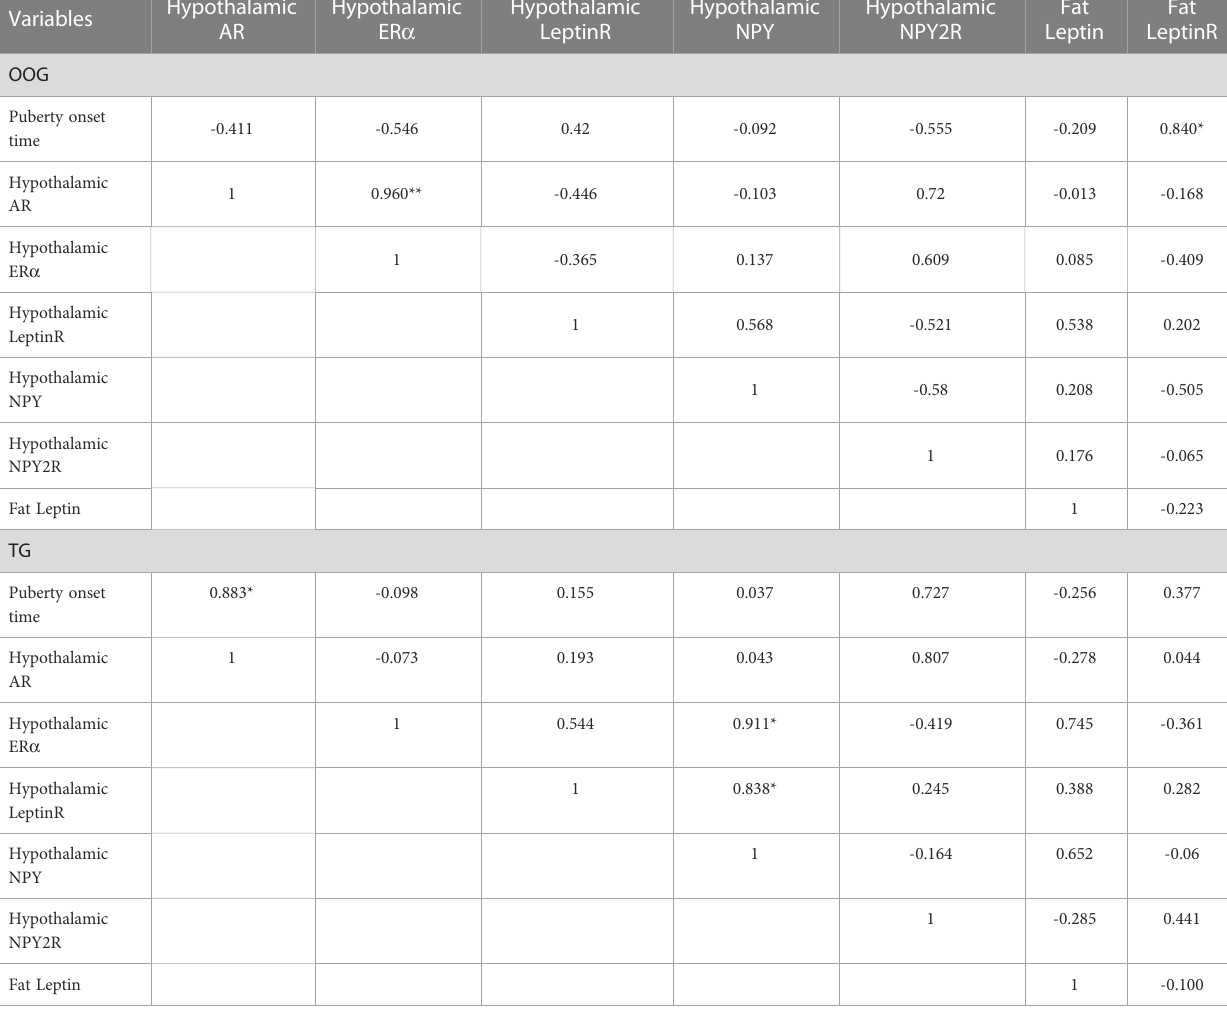
TABLE 5 Correlation between hypothalamic functional gene mRNA levels and the time of onset of puberty in offspring of OOG and TG. Variables